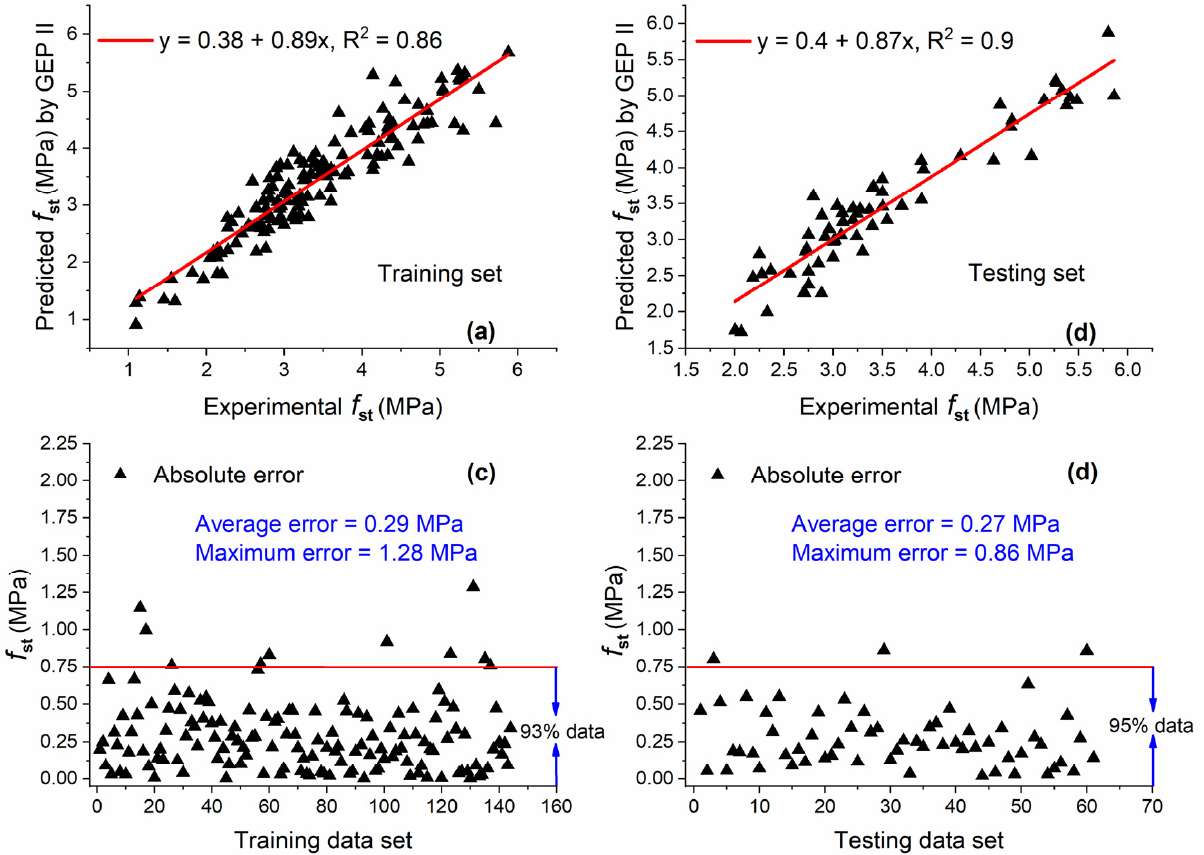
Figure 12. Experimental and predicted values of f st by GEP II for ( a ) training set and ( b ) testing set, and their corresponding absolute error for ( c ) training data set and ( d ) testing data set.